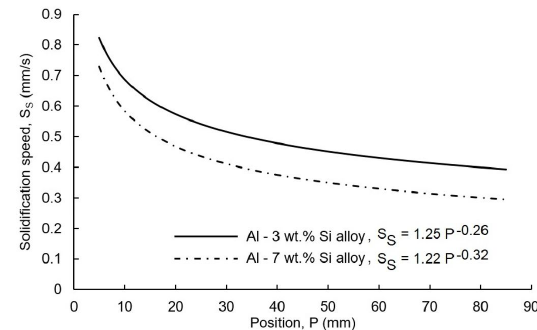
Figure 8. Solidification speed ( S